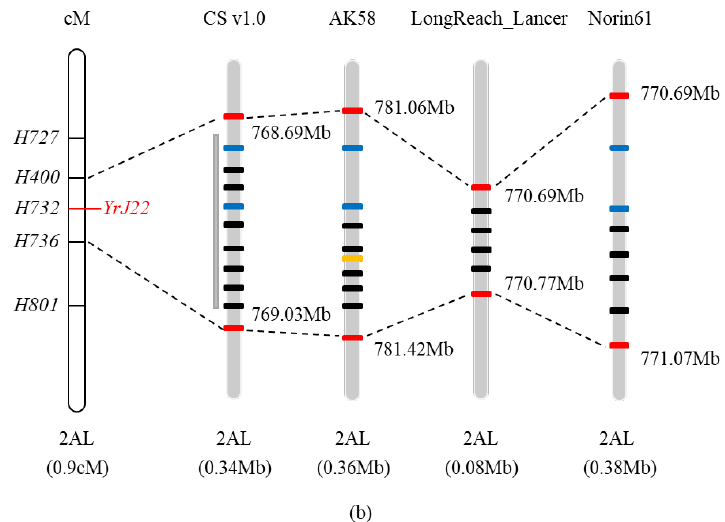
Figure 4. ( a ) Linkage and physical maps for stripe-rust-resistance gene YrJ22 on chromosome arm 2AL. Loci names are indicated on the right side of the map. Kosambi map distances (cM) are shown on the left side. The physical positions refer to Chinese Spring RefSeq v1.0 (http://www.wheatgenome.org/, accessed on 20 October 2021). ( b ) Collinearity analysis of the target genomic-interval on chromosome 2AL in Chinese Spring RefSeq v1.0 with three Triticum species. The picture shows collinear interval of three Triticum species flanked by H727 and H736 , marked as red rectangles. The blue ones show the R -gene within the region. The yellow one indicates the position of novel genes in the target interval of the three species.